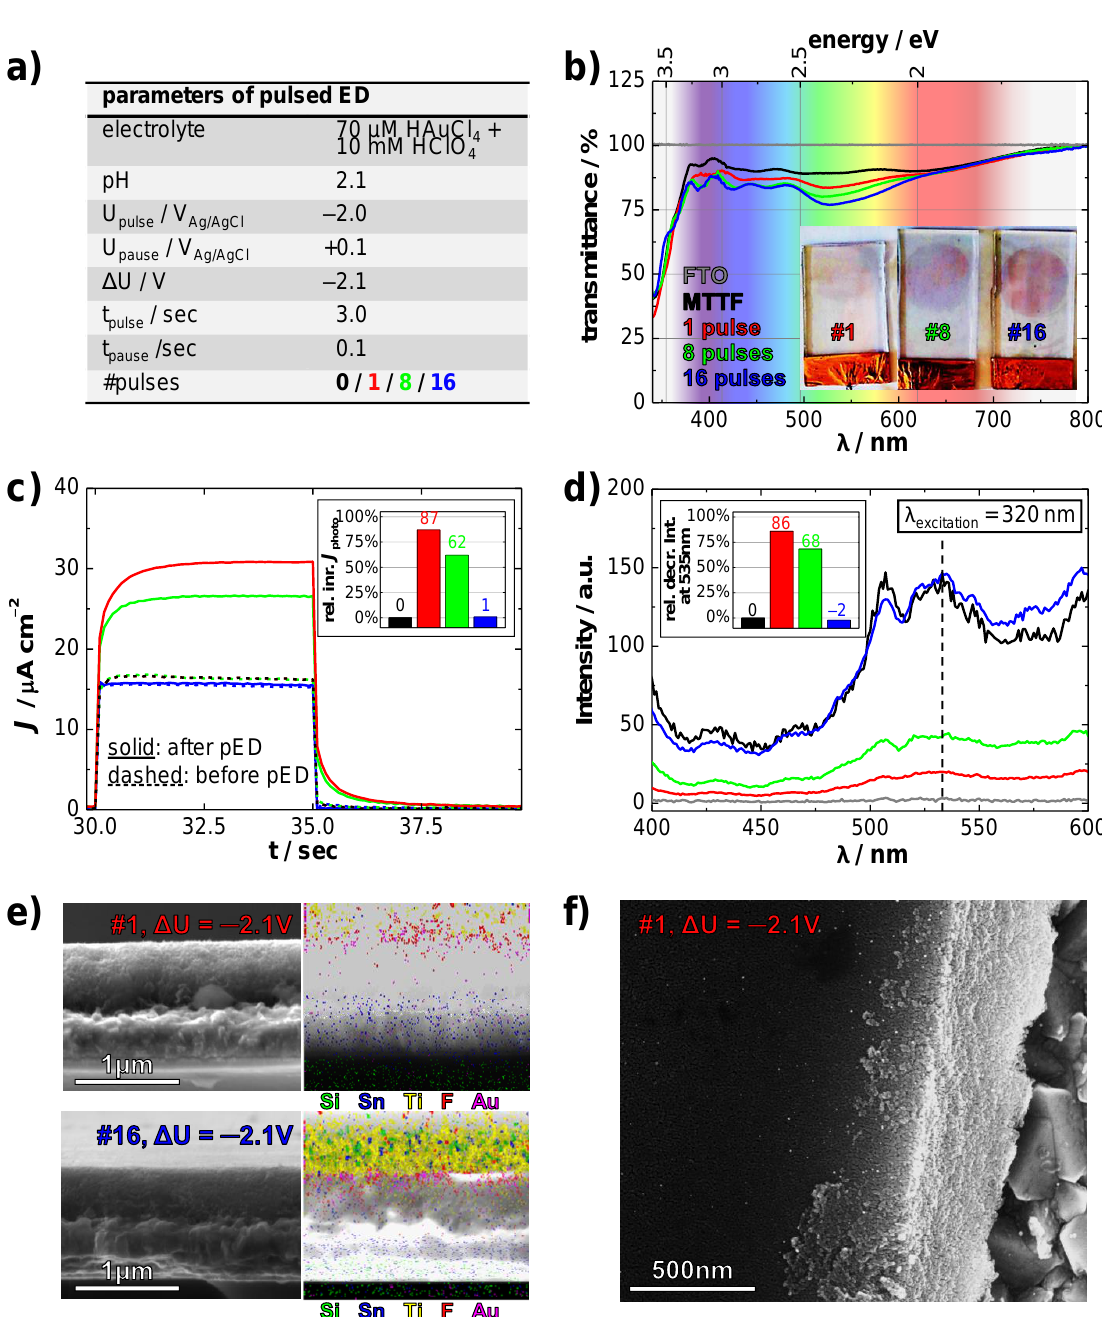
Figure 14. Properties of SPR-active gold-modified MTTFs obtained after three different amounts of applied cathodic pulses. ( a ) physicochemical conditions and pulse parameters during pulsed electrodeposition, ( b ) UV/Vis transmittance spectra and photograph, ( c ) chronoamperometric results (dashed and solid lines before and after pulsed-ED, respectively) with inset showing relative increase of photocurrents, ( d ) fluorescence spectra with inset showing relative decrease of emission intensity, ( e ) cross-sectional SEM images and corresponding EDX mapping of two selected samples, ( f ) top-view SEM image of most active sample near a cracked part showing